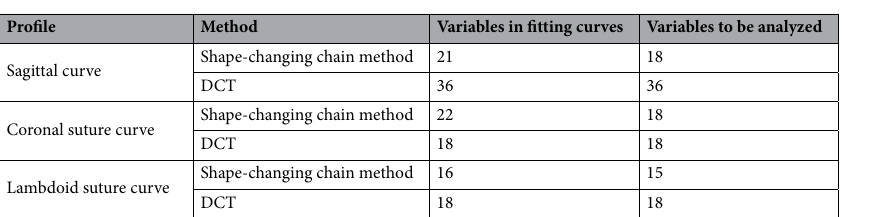
Figure 16. The 2D canonical plots of the suture curves selected from 63 skull samples. ( a ) The sagittal curves based on 6 variables. ( b ) The coronal sutures based on 7 variables. ( c ) The lambdoid sutures based on 8 variables.